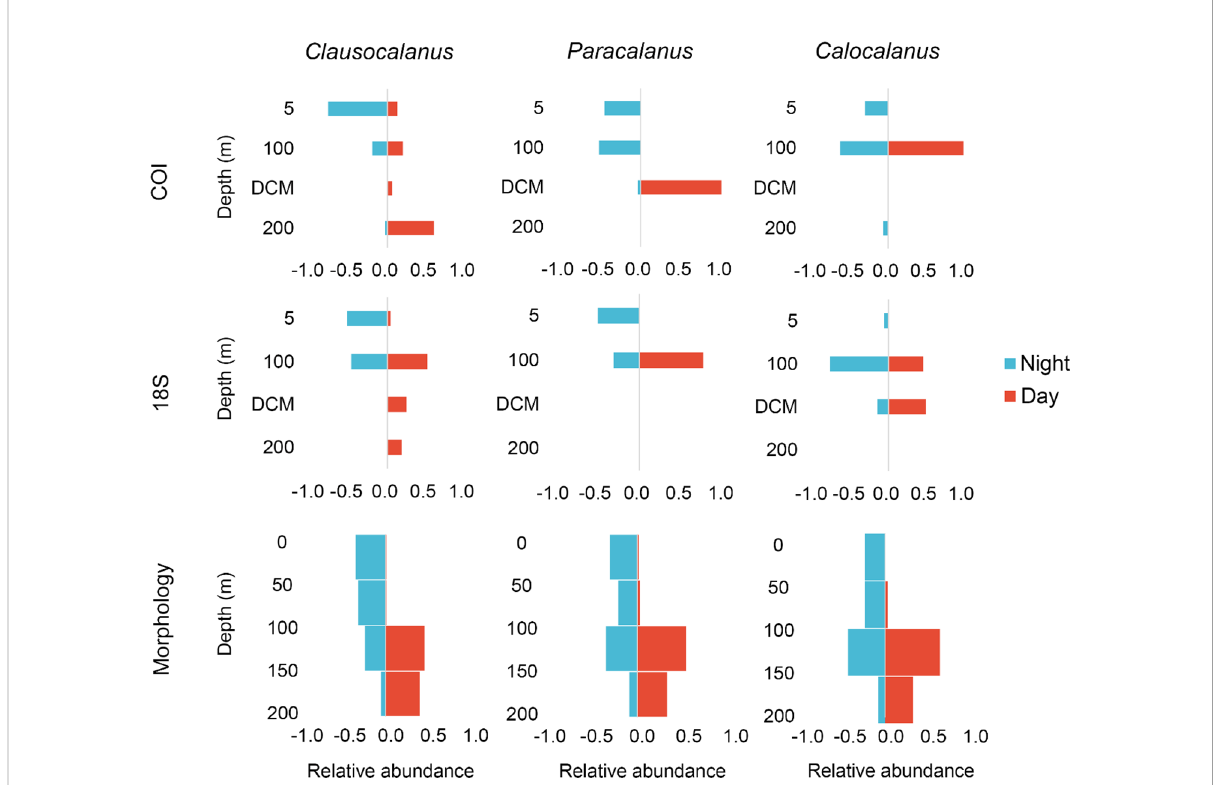
FIGURE 7 Diel vertical distribution plots of the genera Clausocalanus , Paracalanus , and Calocalanus from surface to 200 m. The eDNA data that were used to calculate relative abundance represent a sum of all ASVs identi fi ed as each